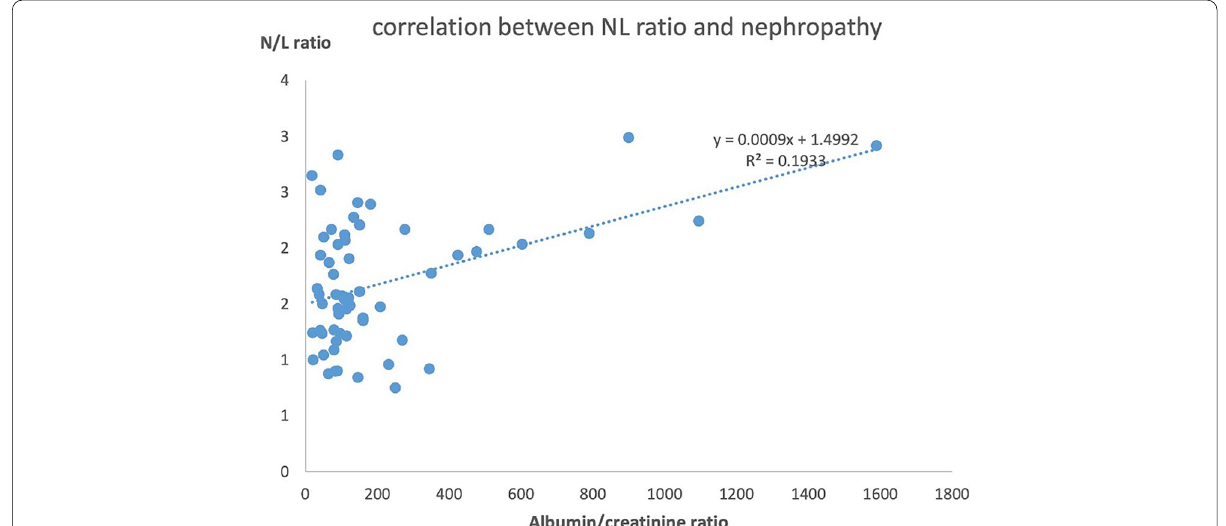
Fig. 4 Showing the correlation of NLR and DN in T2DM geriatric patients